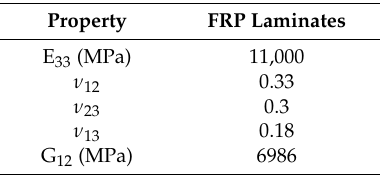
Table 5. Mechanical properties of materials for the FE